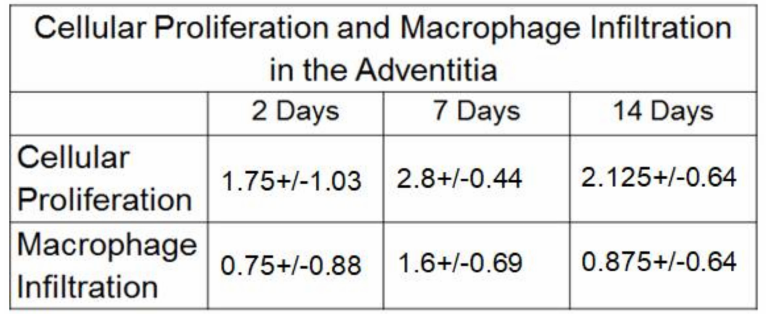
Figure 2. Semi-quantitative scoring for cellular proliferation and macrophage infiltration.